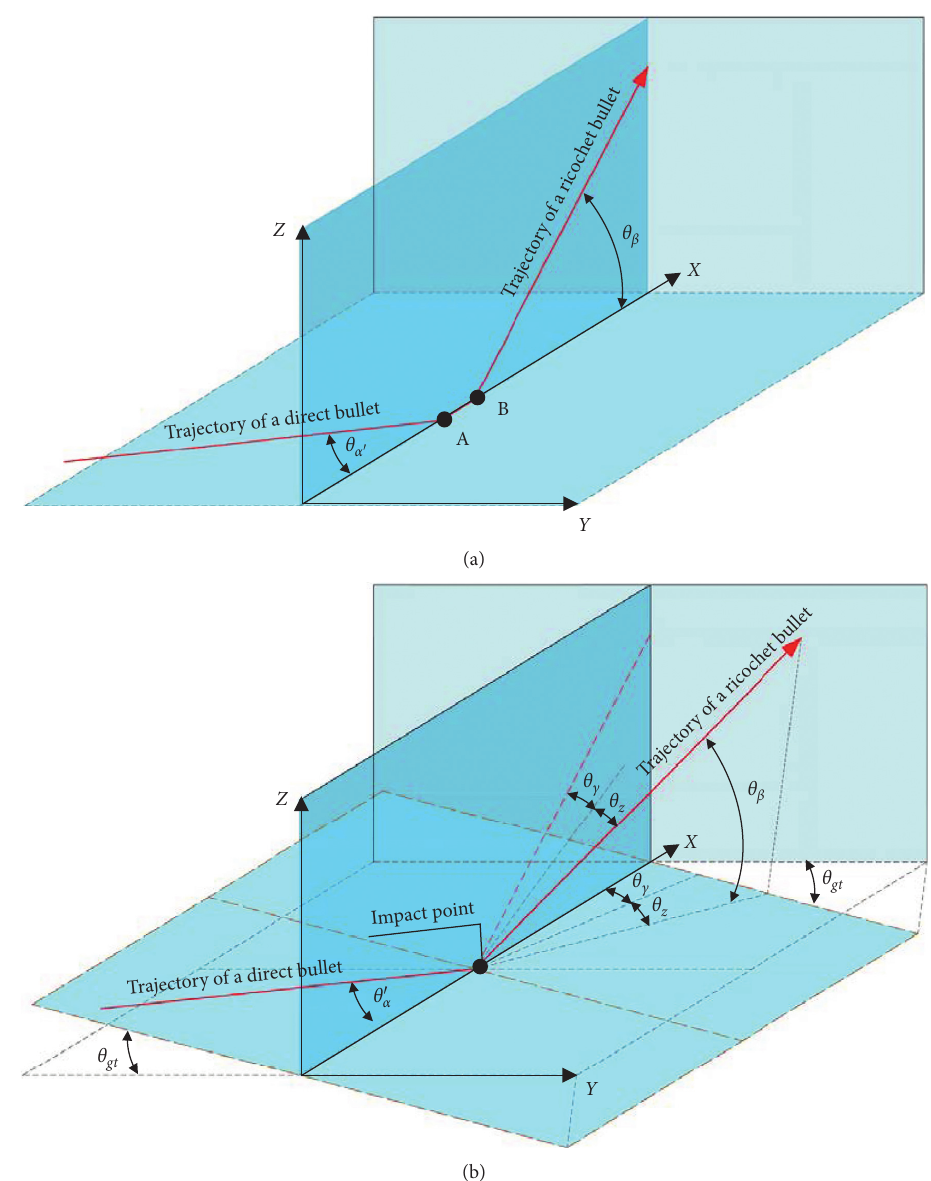
Figure 1: Components for calculation of a ricochet’s trajectory. (a) Terrain without ground inclination. (b) Terrain with ground inclination angle in the transverse direction θ gt